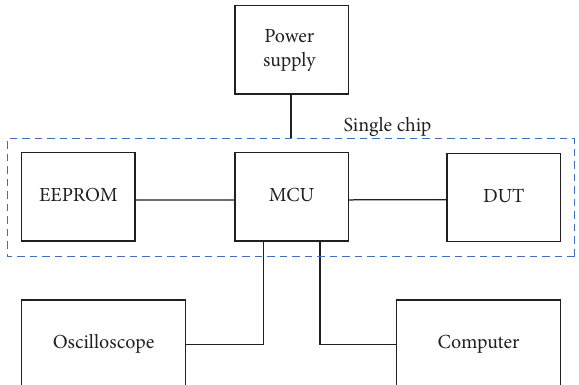
Figure 9: Composition of the test system.